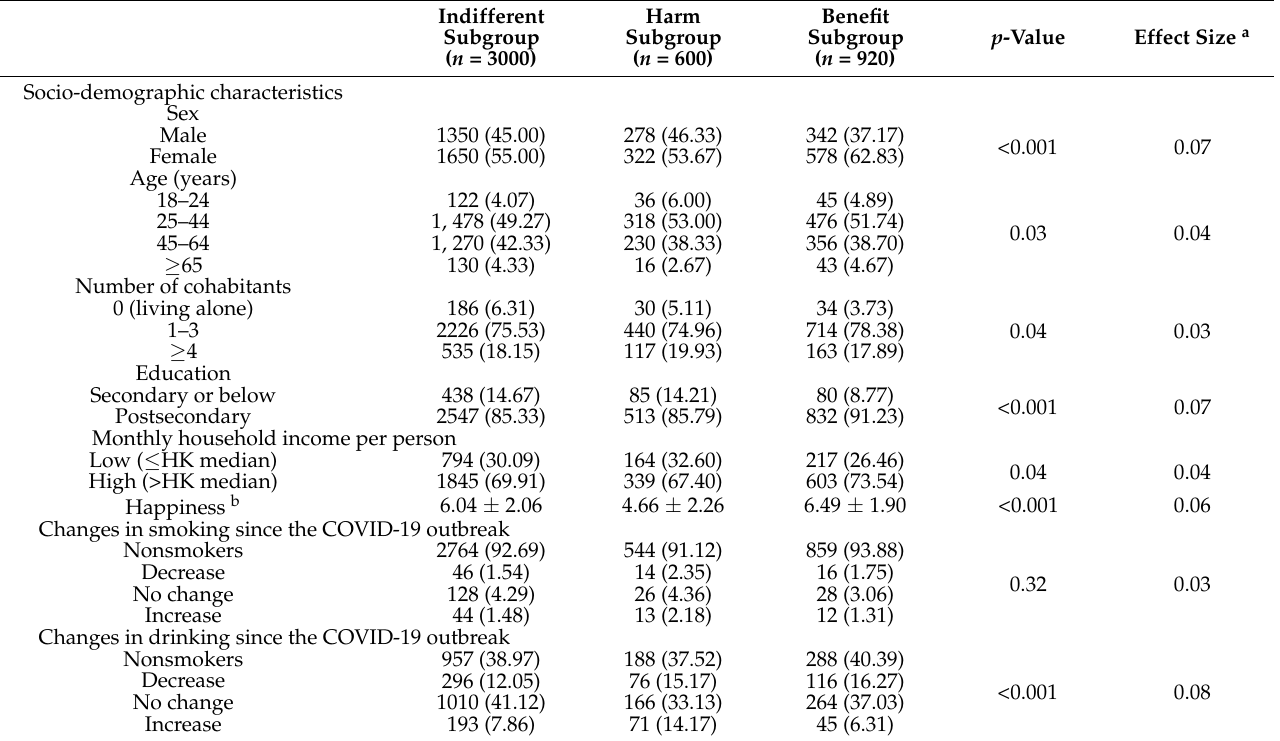
Table 4. The characteristics of socio-demographics, happiness, and changes in smoking and drinking across three subgroups, unweighted, n (%) or Mean ± Standard deviation (N = 4520). Harm Benefit Indifferent Subgroup p -Value Effect Size a Subgroup Subgroup ( n = 600) ( n = 3000) ( n = 920)